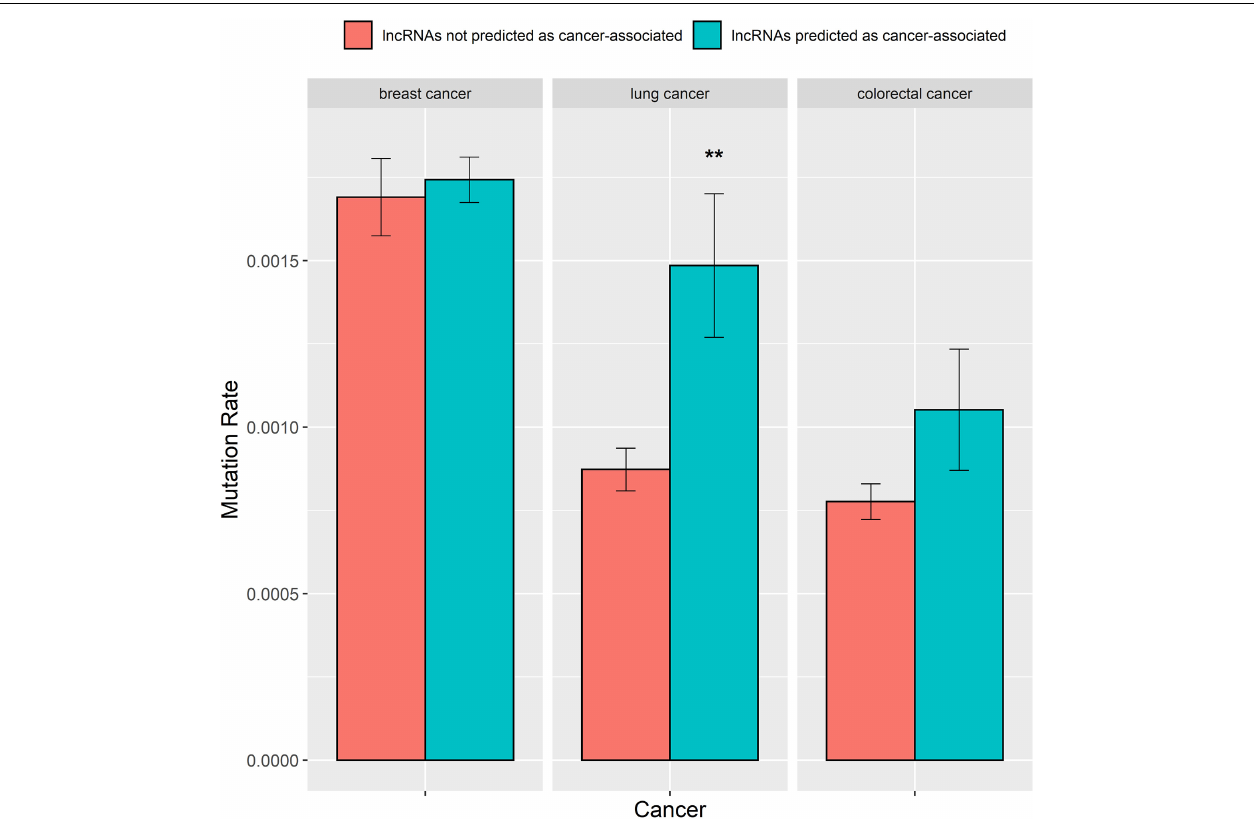
FIGURE 5 | The mutation rates in the lncRNAs predicted as cancer-associated by DRACA are higher than in the lncRNAs not predicted as cancer-associated. “*” denotes t -test P -value < 5.0–2E; “**” represents t -test P -value < 1.0–2E.